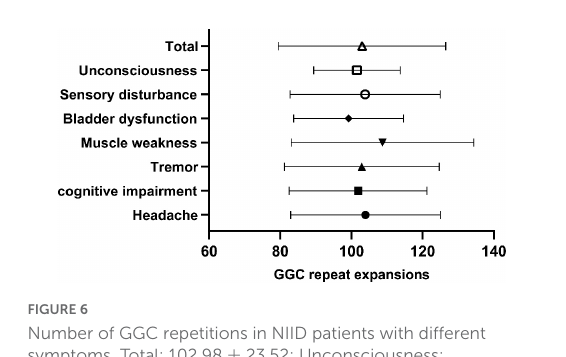
FIGURE6 Number of GGC repetitions in NIID patients with different symptoms. Total: 102.98 ± 23.52; Unconsciousness: 101.53 ± 12.17; Sensory impairment: 103.84 ± 21.09; Bladder dysfunction: 99.17 ± 15.46; Muscle weakness: 108.74 ± 25.66; Tremor: 102.885 ± 21.76; Cognitive impairment: 101.84 ± 19.35; Headache: 103.94 ± 21.03.